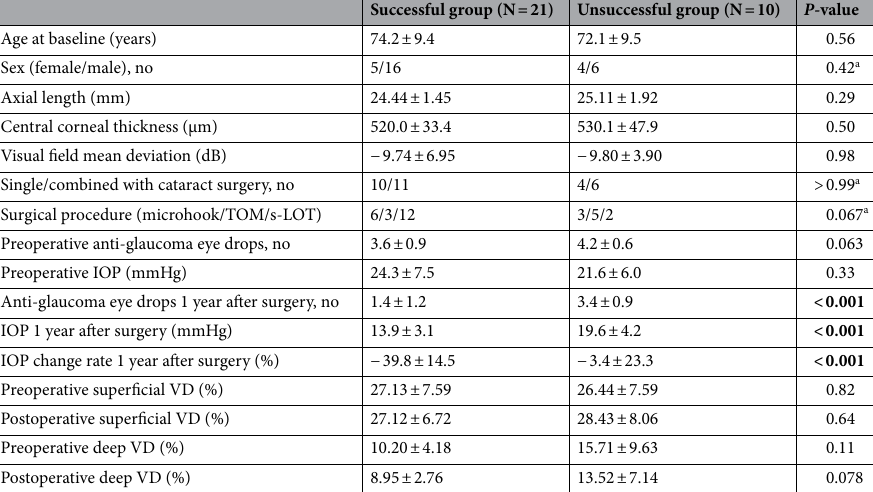
Table 4. Comparison of successful and unsuccessful groups (N = 31). Data are presented as the mean ± standard deviation unless otherwise indicated. IOP, intraocular pressure; s-LOT, suture trabeculotomy; TOM, Trabectome; VD, vessel density. P -value: a Calculated using Fisher’s exact test; The other values were calculated using an unpaired t- test. Significant values are in